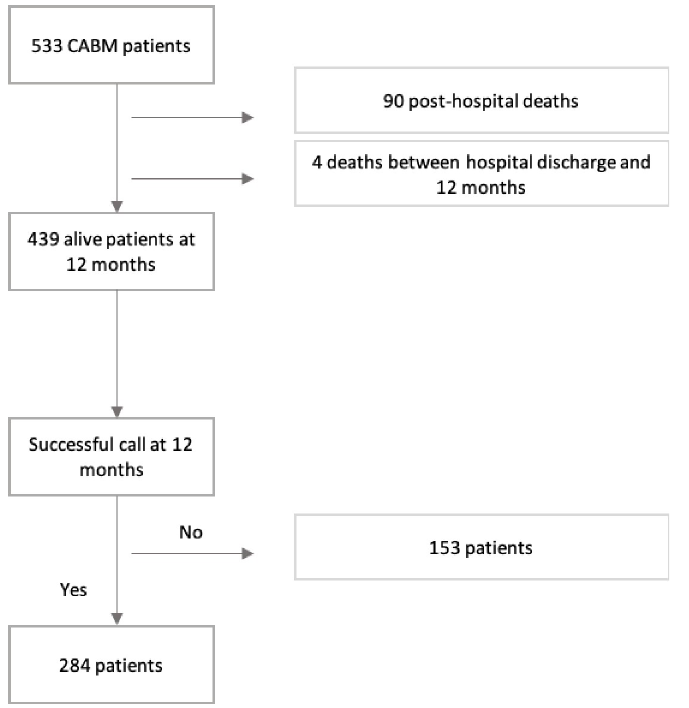
Fig 1. Flow chart of the study sample (N = 284), COMBAT France, 2013–2015.